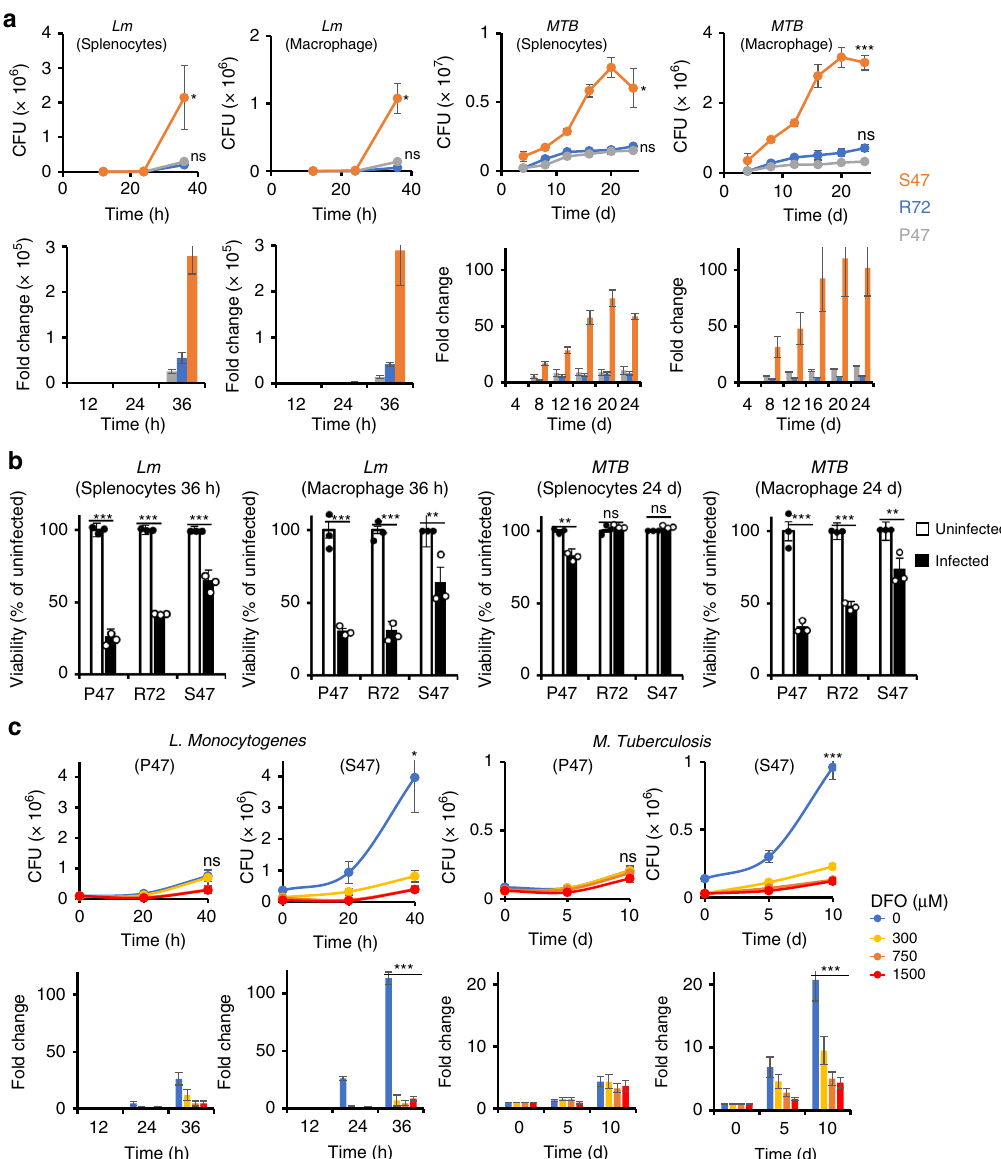
Fig. 2 S47 cells show more intracellular bacterial growth owing to higher iron content. a Splenocyte and monocyte-derived macrophages ( n = 3 biological replicates with three technical replicates) of P47, R72, and S47 mice were infected with Lm (Listeria) or MTB (M. tuberculosis), and bacterial viability was measured at the respective time points by CFU assay. Top panel — raw values, bottom panel fold change over 0 h/d post infection. Error bars represent means± s.e.m. *** P < 0.001, * P < 0.05, ns — not signi fi cant; by unpaired Student ’ s t test, relative to P47 mice. b Splenocyte or macrophage viability with (black bars) or without (white bars) infection at the last time point after infection was measured by Resazurine cell viability assay ( n = 3 biological replicates with three technical replicates). Error bars represent means ± s.e.m. *** P < 0.001, P < 0.01, * P < 0.05, ns — not signi fi cant; by unpaired Student ’ s t test, relative to the uninfected counterpart. c Monocyte-derived macrophages pretreated with PBS or the indicated DFO concentrations were infected with Lm or MTB and bacterial growth was measured by CFU at indicated time points ( n = 3 biological replicates with three technical replicates). Top panel — raw values, bottom panel fold change over 0 h/d post infection. Error bars represent means± s.e.m. *** P < 0.001, * P < 0.05, ns — not signi fi cant; by unpaired Student ’ s t test, relative to the DFO-treated counterpart. Source data are provided as a Source Data fi